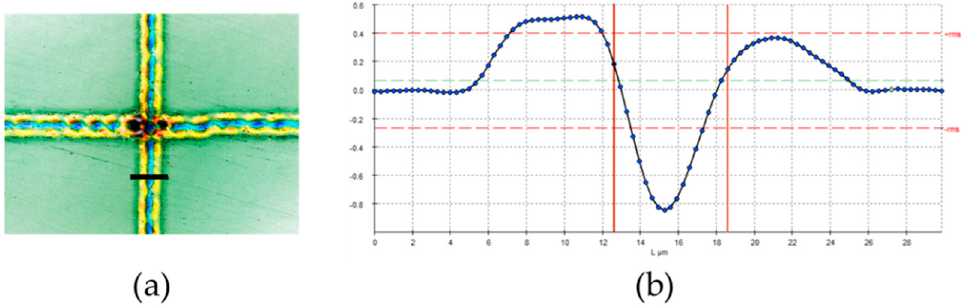
Figure 15. ( a ) Detail of proof of concept pattern seen in a confocal microscope at 50× magnification ( b ) Profile of the